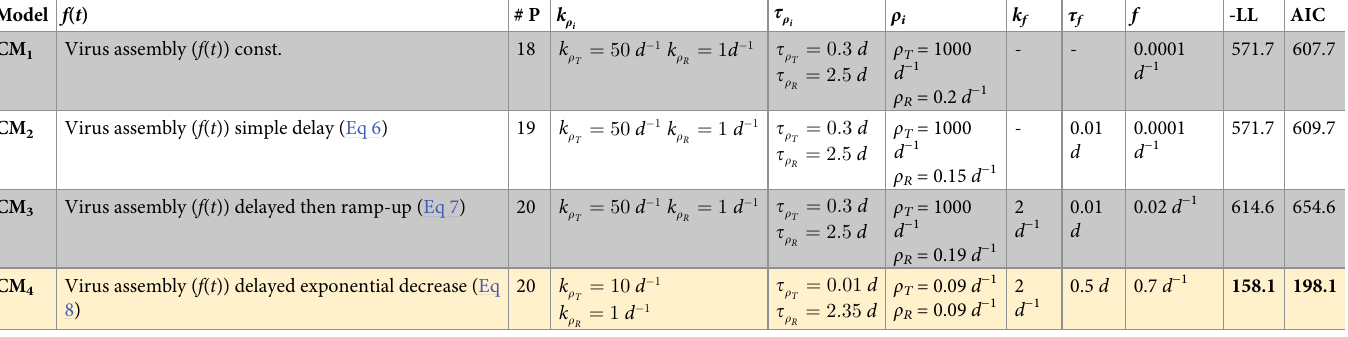
In order to gain insight into the impact of model parameters on the combined model, we per- formed a global sensitivity analysis for all HCV species (plus-strand RNA, minus-strand RNA, secreted RNA, intracellular and extracellular infectious virus) for two different time points, day 1 and day 3 post-infection (see S2 Text and S10 Fig). The amount of secreted HCV RNA was highly sensitive to the rate of cytoplasmic RNA degradation, μ describing the secretion process from the site of translation, τ virus replication and transfer parameters, r , α , τ and C infectious virus at 3 dpi was sensitive to the secretion process parameters, while the amounts of both infectious virus species at 3 dpi were sensitive to the virus assembly and release parameters. Table 6. Model comparison of the CM models. Negative log likelihood (-LL), AICs and number of estimated model parameters (#P) of the combined model (CM) with exosome secretion and virus assembly and release. CM 1 to CM 4 were each fitted to plus-strand RNA, minus-strand RNA, secreted HCV RNA, intracellular and extracellu- lar virus from Keum et al. [35]. The model with the lowest AIC is highlighted in beige. Model f ( t ) Virus assembly ( f ( t )) const.